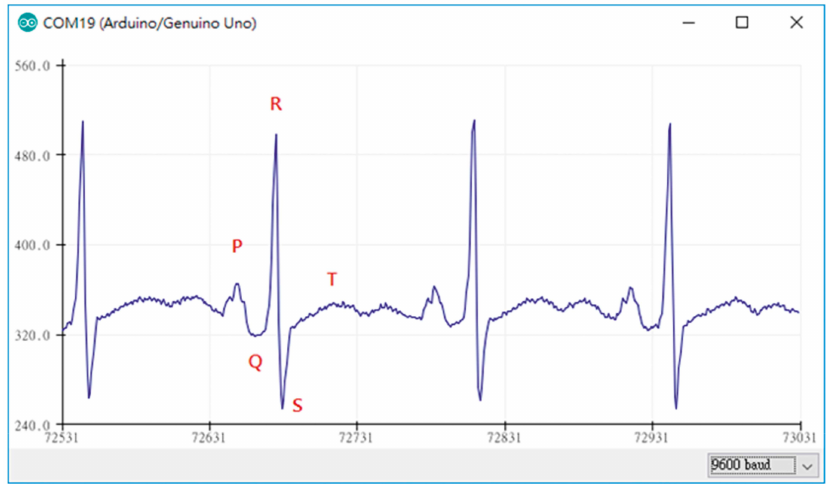
Figure 4. ECG measurement plot obtained by the Arduino device in combination with AD8232. From [66], originally published under a CC-BY